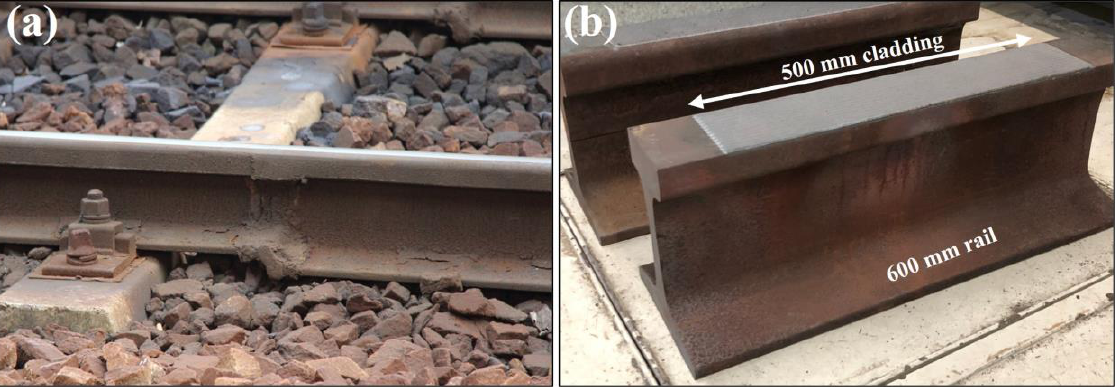
Figure 1. ( a ) Thermite welded rail by Bombarda et al. [5], ( b ) laser cladding deposition on rail by Kendall et al. [6].